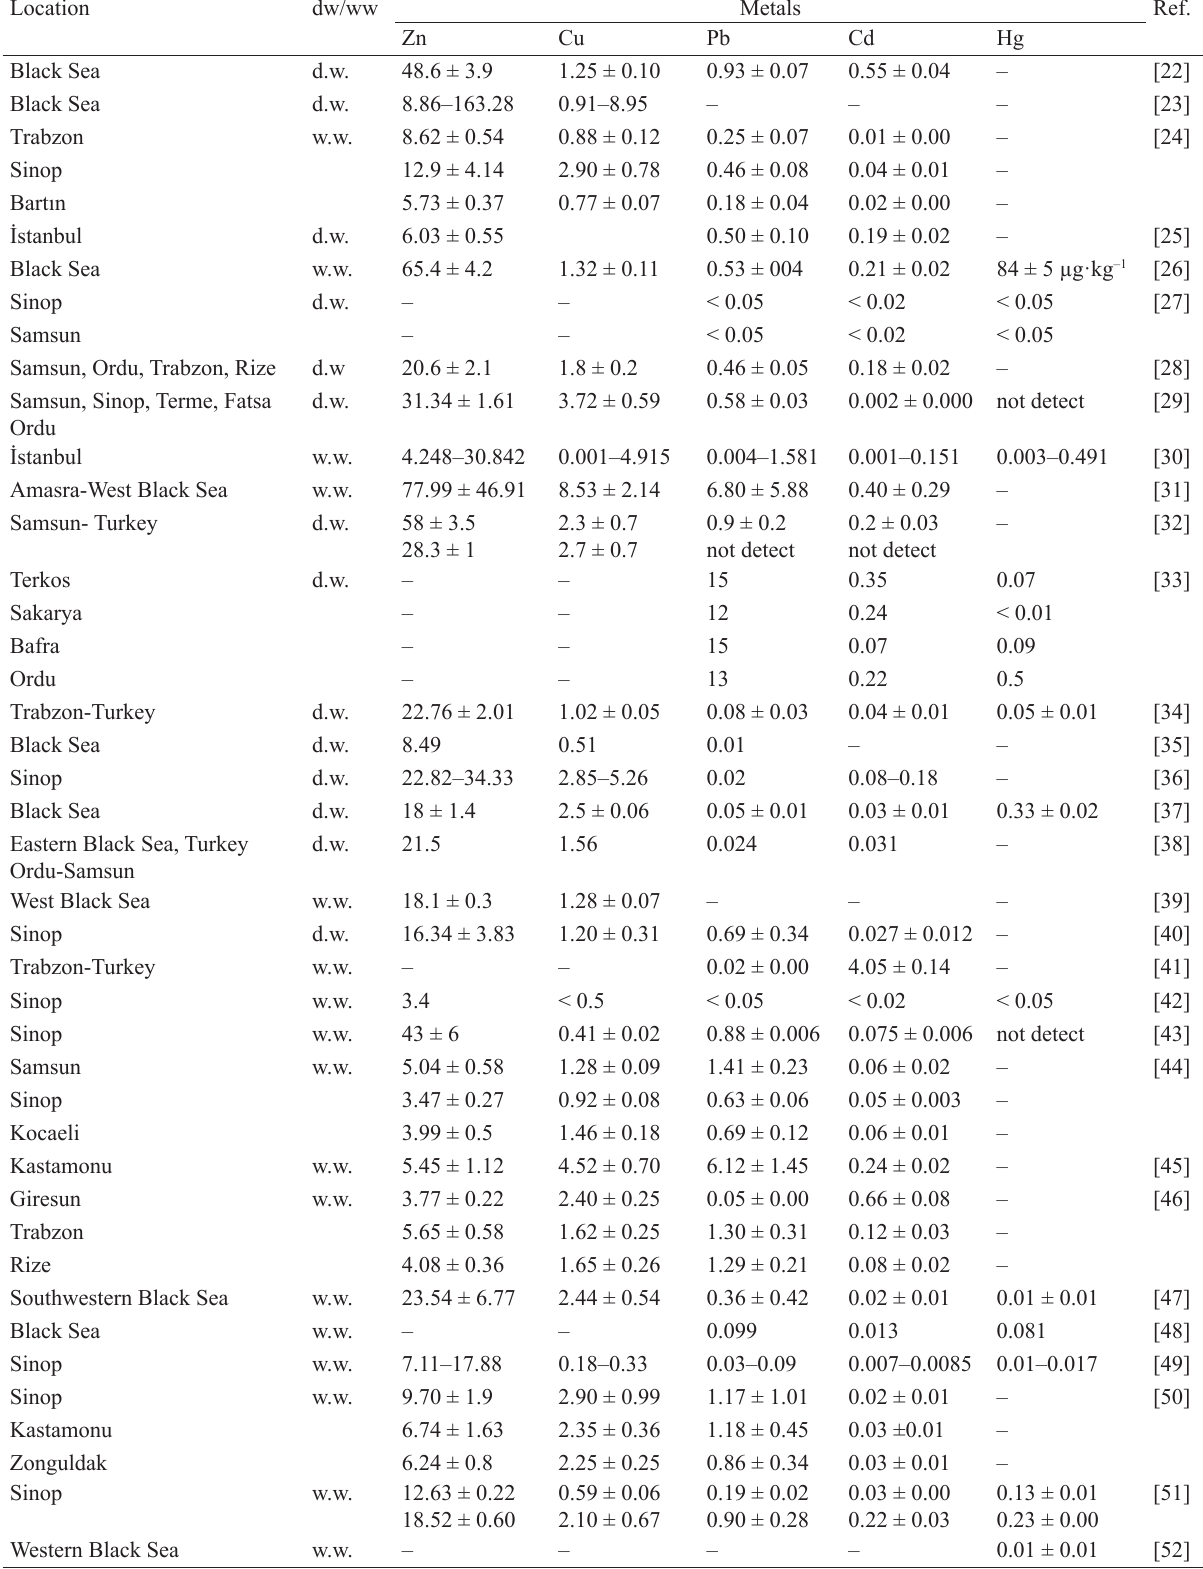
Table 7 Comparison of the amounts (ppm) of heavy metals in the edible tissues of Merlangius merlangus L. caught near various areas of the Black Sea